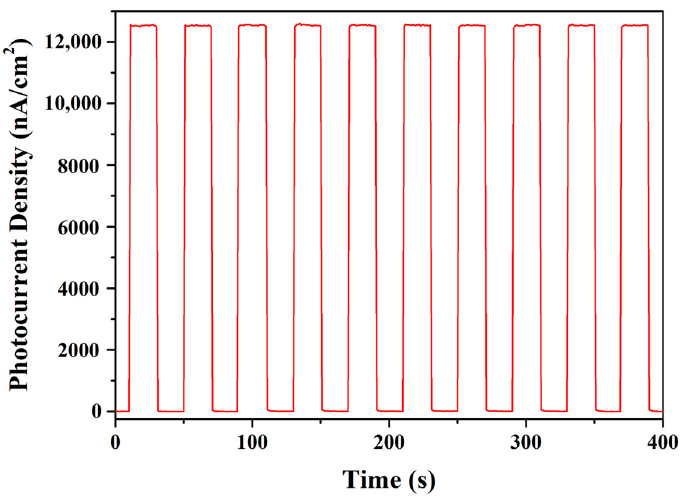
Figure 9. Photocurrent response stability of the 0.5 wt.% Au/TiO 2 NT electrode in 50 µ M glucose solution.